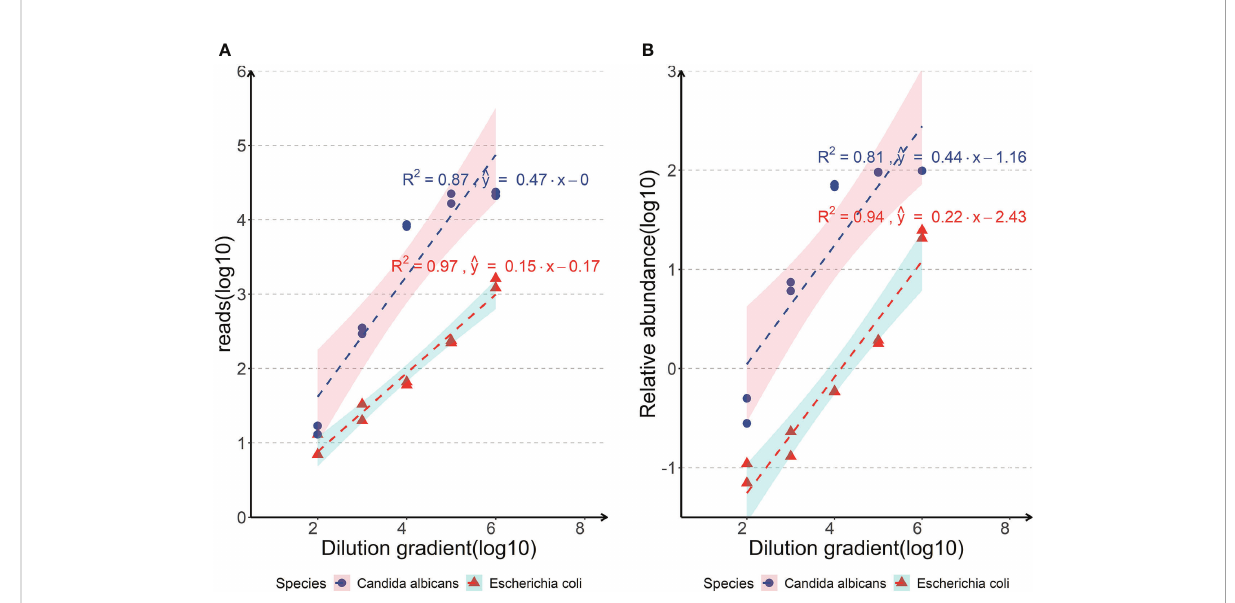
FIGURE 2 Analyses of the limits of detection of the nanopore amplicon sequencing assay in detecting Escherichia coli or Candida albicans of body fl uid samples. ( A , Correlations between the reads of the pathogen detected by nanopore amplicon sequencing and the dilution gradient of pathogens spiked in negative sputum; B , Correlations between the relative abundance of the pathogen detected by nanopore amplicon sequencing and the dilution gradient of pathogens spiked in negative